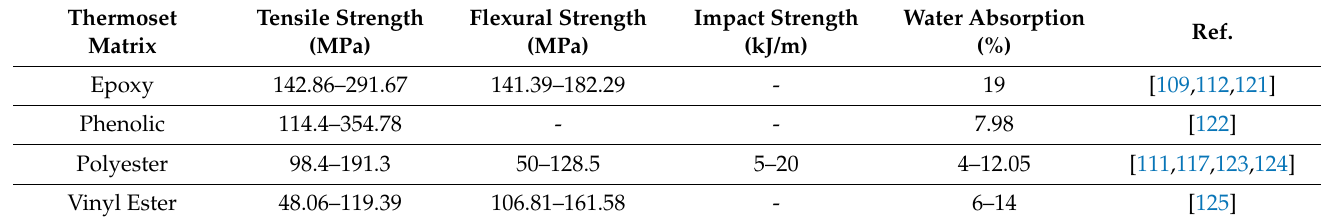
Table 11. Mechanical and physical properties of bamboo-reinforced thermoset